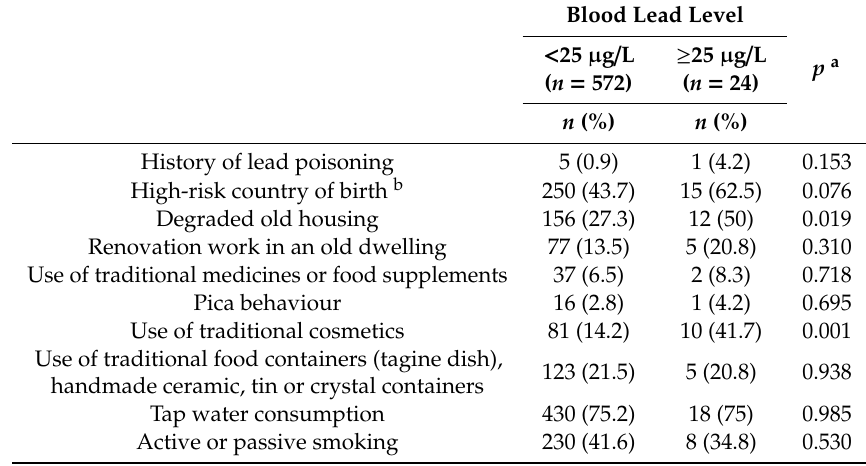
Table 2. Univariate analysis of exposure sources according to the level of lead impregnation ( n =